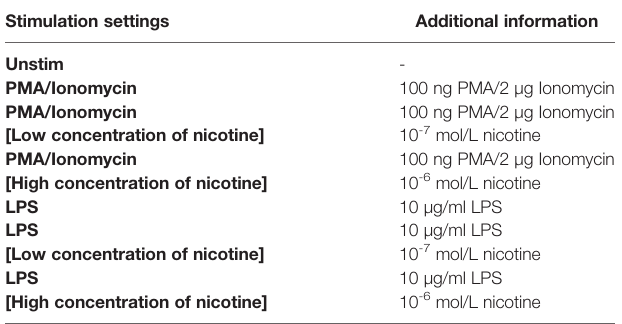
TABLE 3 | Used conditions for different stimulation settings for ICS assay.